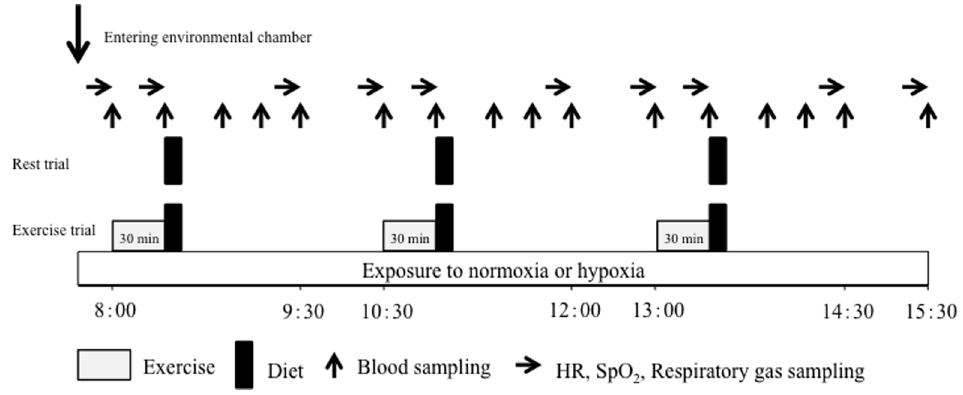
Figure 1. Overview of the study design.